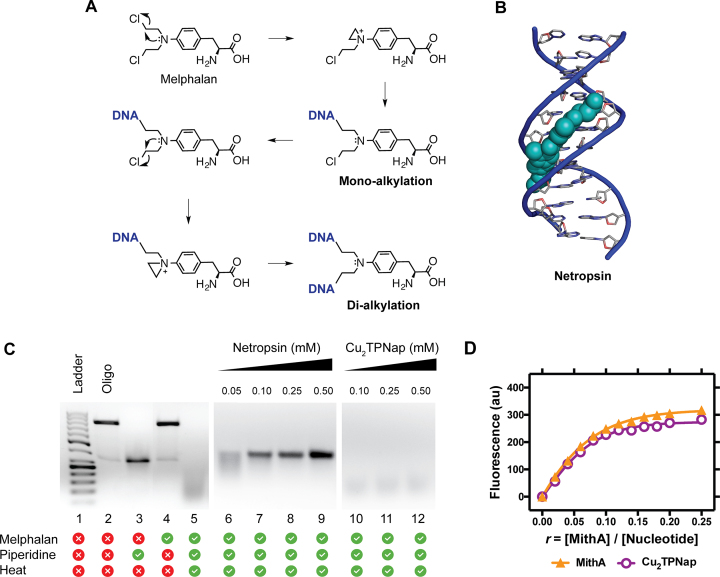
(A) Mechanism of DNA alkylation by nitrogen mustard melphalan; (B) minor groove binding agent netropsin binding to the minor groove of Dickerson Drew dodecamer (PDB 4C64); (C) melphalan protection assay with netropsin (lanes 6–9) and Cu2TPNap (lanes 10–12) and (D) fluorescence binding of mithramycin A (MithA) to poly[d(G-C)2] in the presence and absence of Cu2TPNap (r = 0.10).